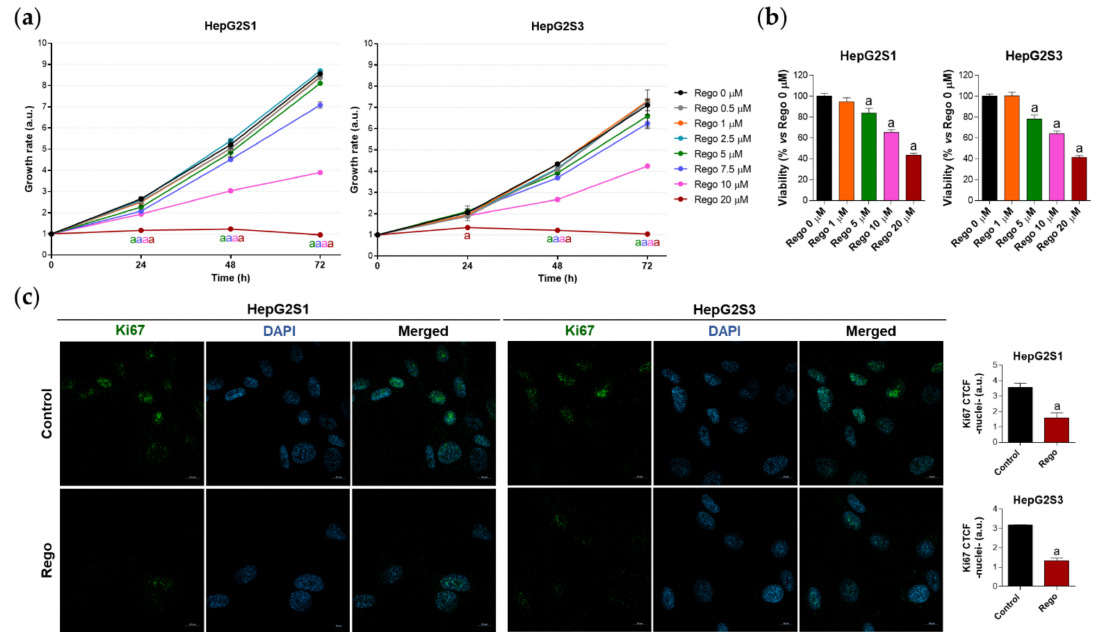
Figure 6. Evaluation of HepG2S1 and HepG2S3 cell growth, viability, and proliferation after treatment with regorafenib. ( a ) Determination of cell growth during 24, 48 and 72 h under several concentrations of regorafenib (Rego) ranging from 0 to 20 µ M using crystal violet staining. a p < 0.05 significant differences between each dosage and Rego 0 µ M at each timepoint; ( b ) Analysis of cell viability at 48 h post-treatment with diverse concentrations of regorafenib ranging from 0 to 20 µ M using 3-(4,5-dimethylthiazol-2-yl)-2,5-diphenyl-tetrazolium bromide (MTT) assay. a p < 0.05 vs. Rego 0 µ M; ( c ) Assessment of proliferation rate by Ki67 immunofluorescence and confocal microscopy after treatment with 20 µ M regorafenib for 48 h. Green fluorescence, Ki67. Blue, cell nucleus. Magnification 63 × , scale bar 10 µ m. Quantification of nuclear green fluorescence (Ki67) is also shown. a p < 0.05 vs. control (non-treated) cells. Data from ( a , c ) are expressed as mean values of arbitrary units (a.u.) ± SD of three independent experiments. Data from ( b ) are expressed as the percentage of the mean values ± SD of three independent